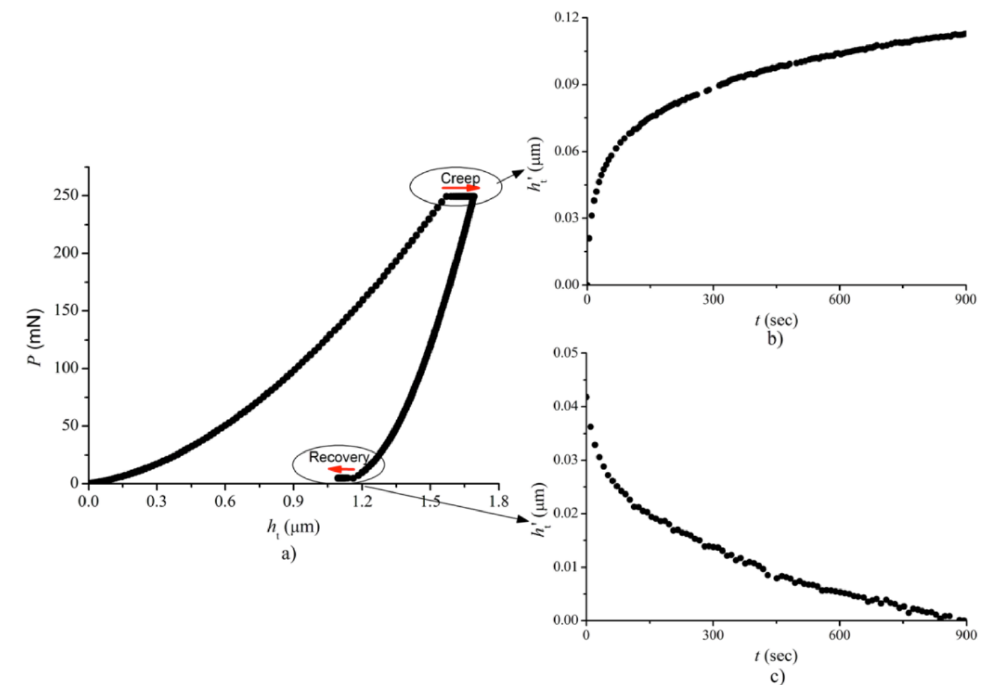
Figure 6. Indentation force-displacement a) plus creep response of enamel b) at max load and c) at very low load ??